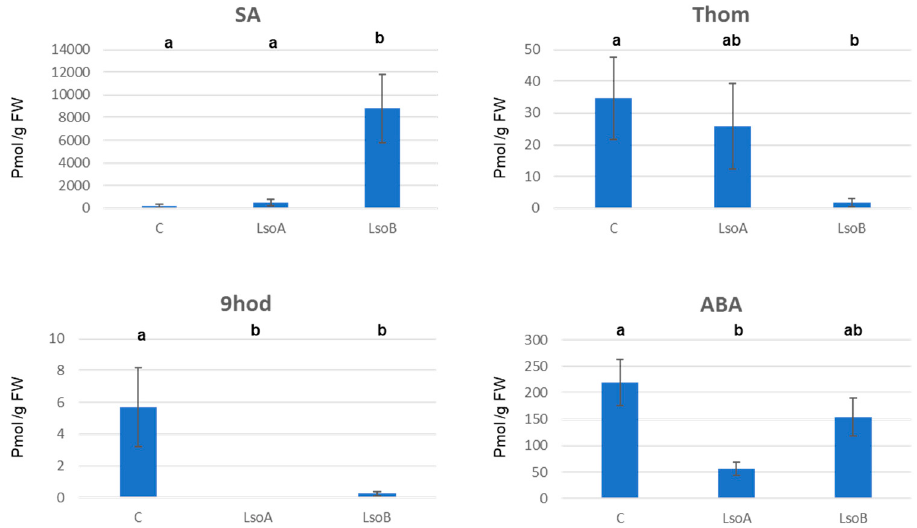
Figure 4. SA and other metabolites